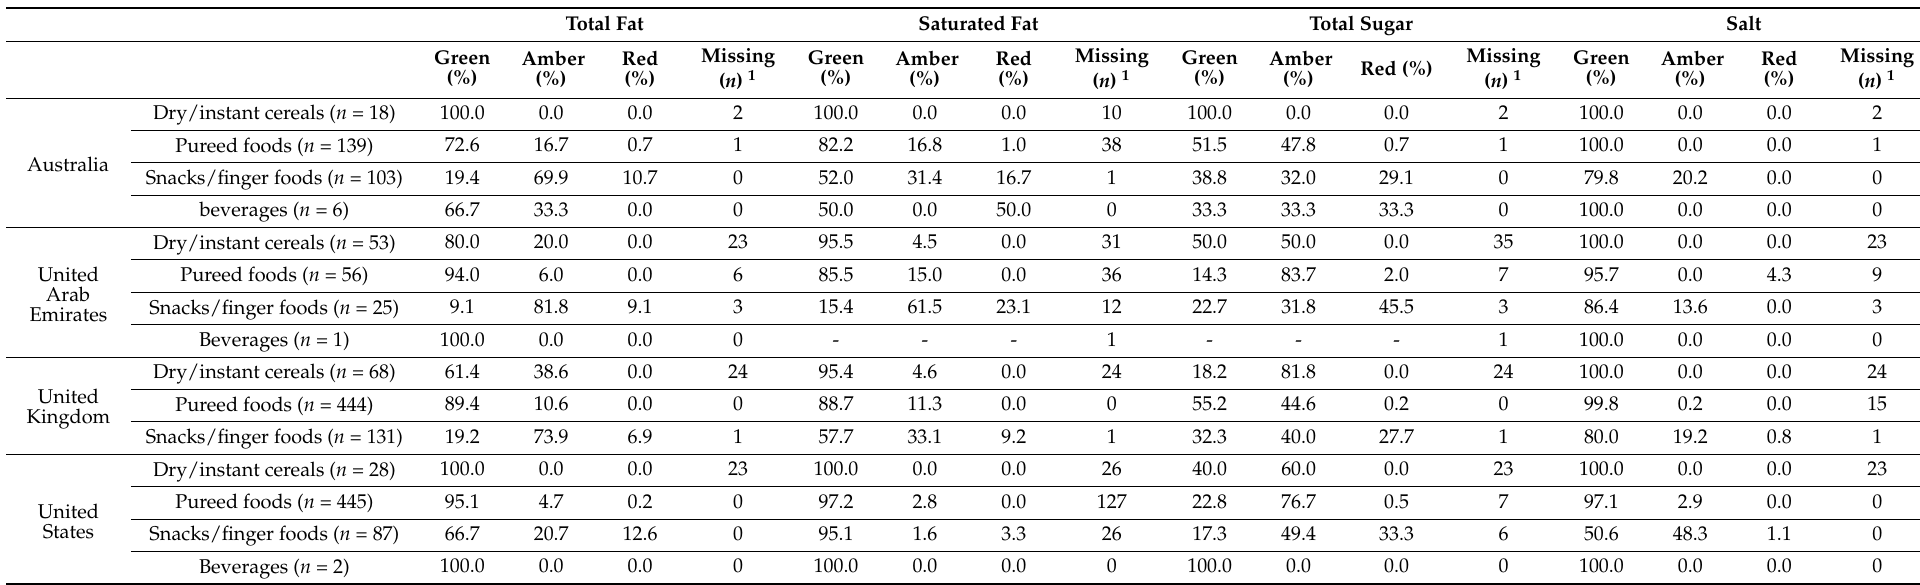
Table 5. Proportion of commercially produced complementary foods warranting a green, amber or red traffic